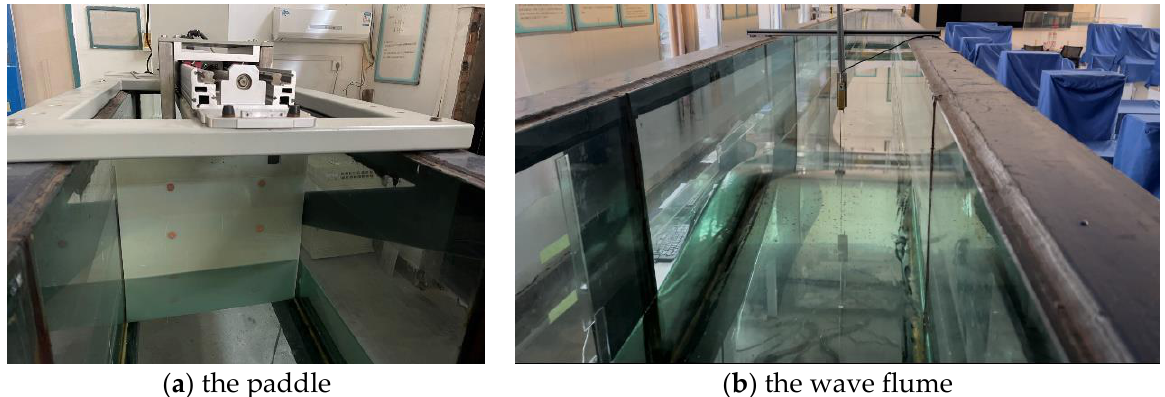
Figure 3. The wave flume at Wuhan University of Technology.